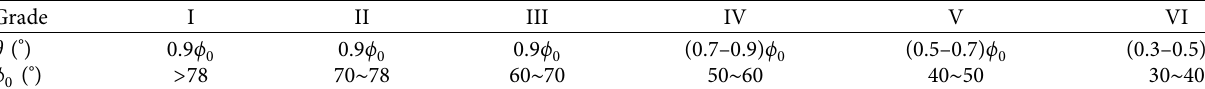
Figure 5: Calculation diagram. Table 1: θ and ϕ value of all grade of surrounding rock (China’s Code for Design of Railway Tunnels ). 0